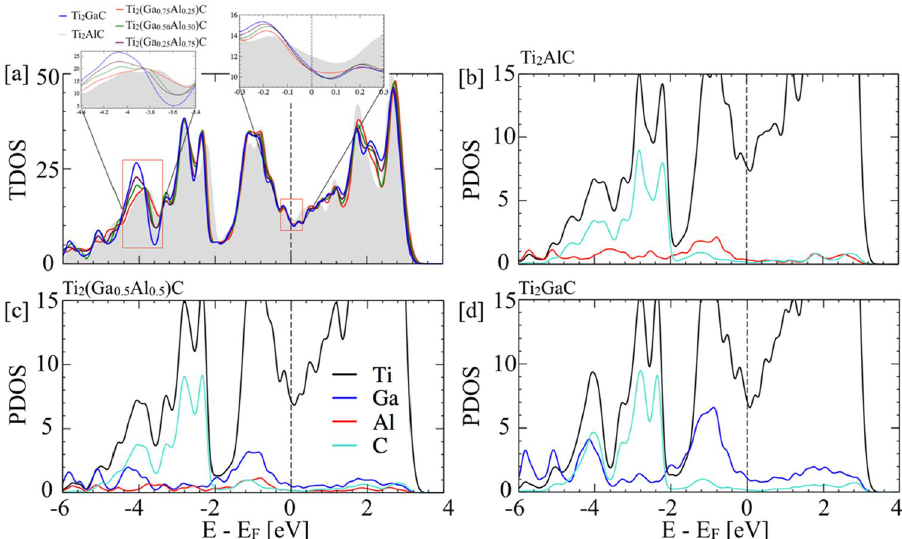
Figure 10. ( a ) The total density of states (DOS) with A-site disorder by Ga in Ti 2 AlC MAX. ( c , d ) The partial DOS of Ti